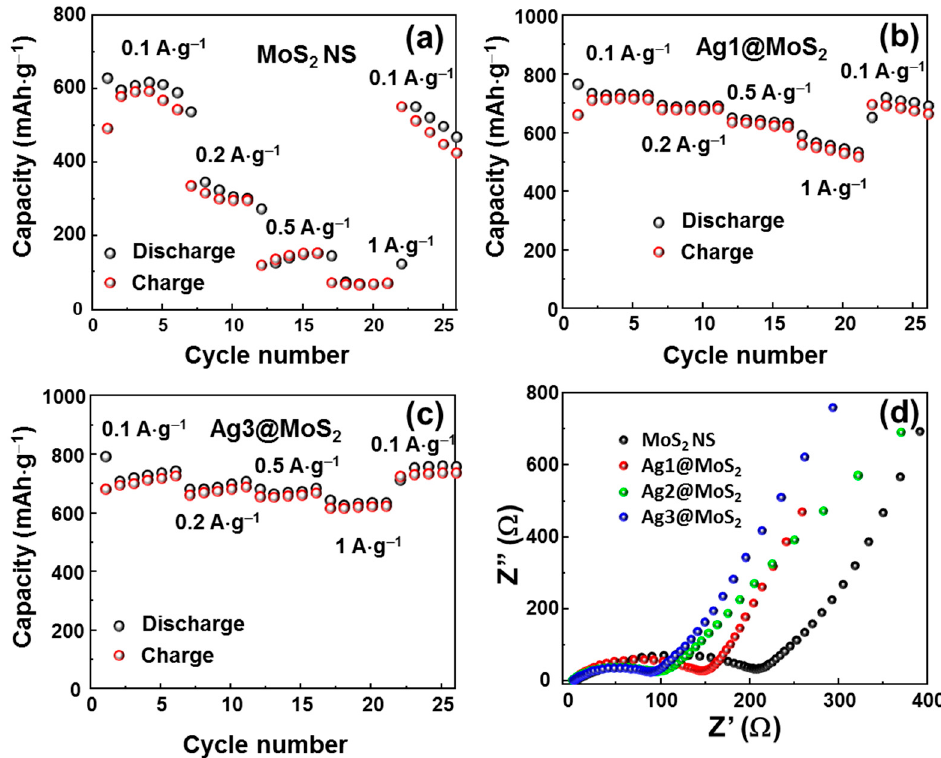
Figure 7. Rate performance of ( a ) MoS 2 NSs, ( b ) Ag1@MoS 2 , ( c ) Ag3@MoS 2 , and ( d ) Nyquist plots of MoS 2 without/with Ag-decorated anodes.